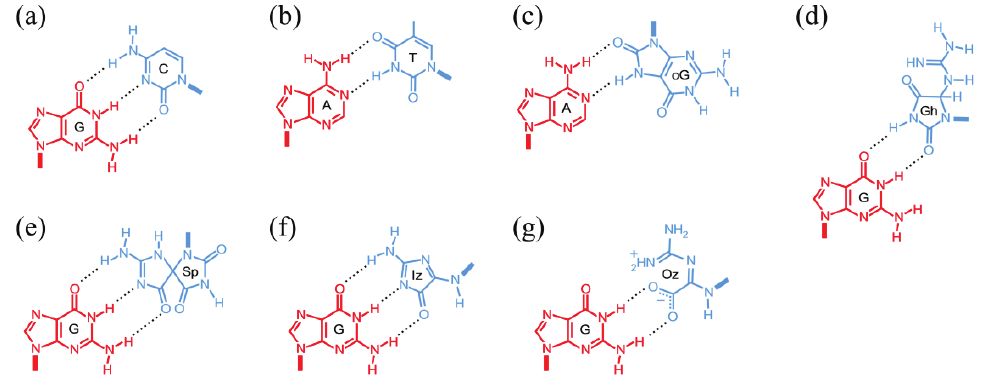
Figure 6. ( a ) Canonical G:C base-pair; ( b ) Canonical A:T base-pair; ( c ) 8-oxoG( syn ):A( anti ) base-pair; ( d ) Gh:G base-pair; ( e ) Sp:G base-pair; ( f ) Iz:G base-pair; ( g ) Oz:G base-pair. For noncanonical base-pairs, the templating base is shown in